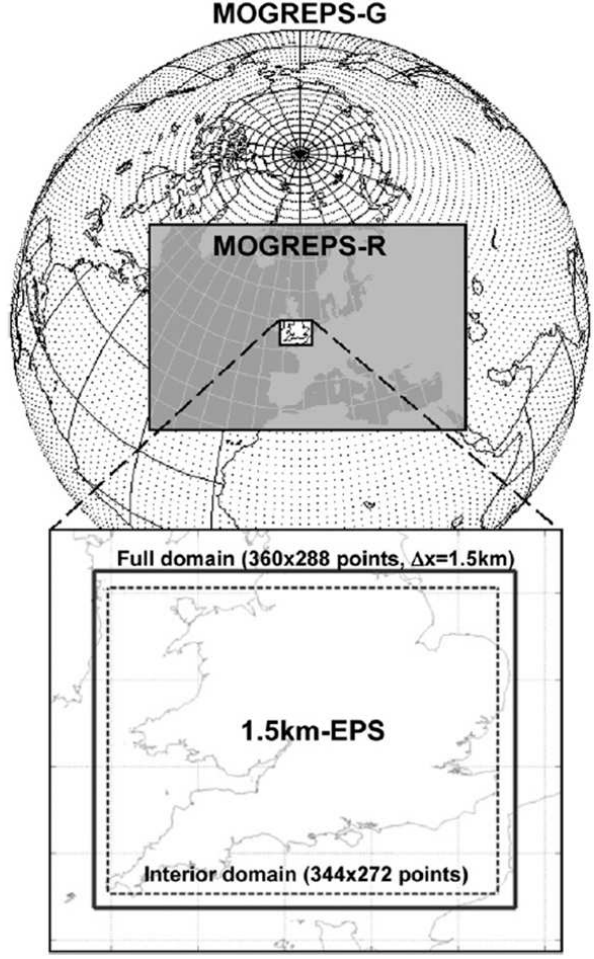
Fig. 1. Schematic diagram showing the model domains of MOGREPS-G, MOGREPS-R and the 1.5km EPS used here. Taken from Fig. 1 of Caron (2013). © Crown Copyright 2013, Met Office.